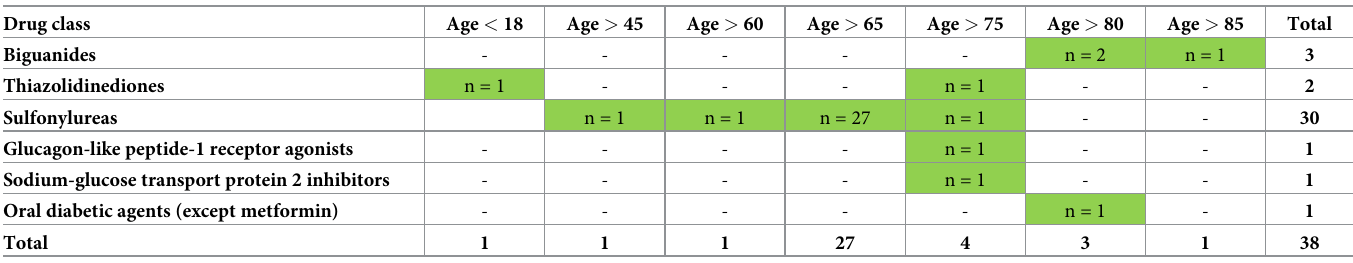
Table 3. Explicit definitions of PIPADs by age